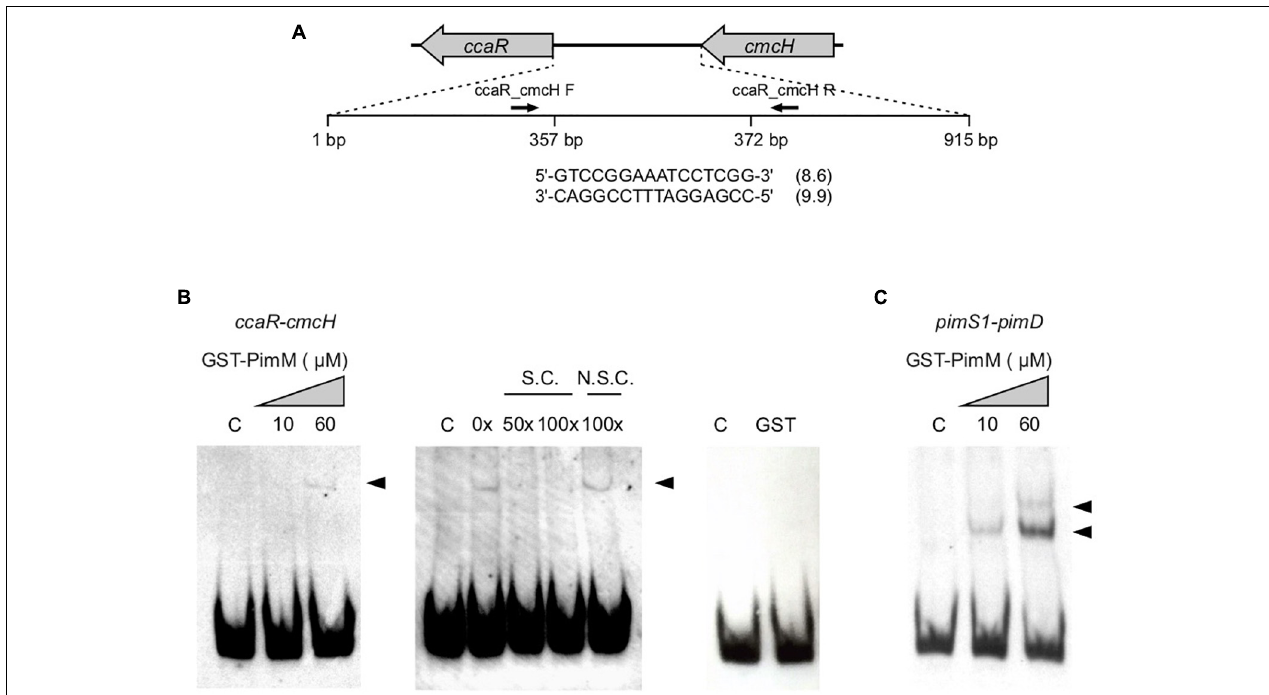
FIGURE 3 | GST-PimM DNA binding assay. (A) Schematic representation of the intergenic region ccaR - cmcH located in the cephamycin C cluster. The nucleotide sequence of the putative PimM-binding site is shown below and the information content ( Ri ) in bits is indicated in parentheses. Sizes are not proportional. (B) Binding of pure GST-PimM to the intergenic region ccaR - cmcH as shown by EMSAs. The DNA fragment was mixed with increasing concentrations of GST-PimM (0–60 µ M) (left panel). The central panel shows a competition experiment between labeled and growing concentrations of unlabelled probe. Right panel, control reaction with 60 µ M pure GST protein. C, reaction without protein; N.S.C., non-specific competitor DNA; S.C., specific competitor DNA. DNA-protein complexes are indicated by arrowheads. (C) Binding of pure GST-PimM to the intergenic region pimS1-pimD from S. natalensis (containing two PimM-target sequences) as shown by EMSAs. The reaction conditions were the same as for the ccaR-cmcH